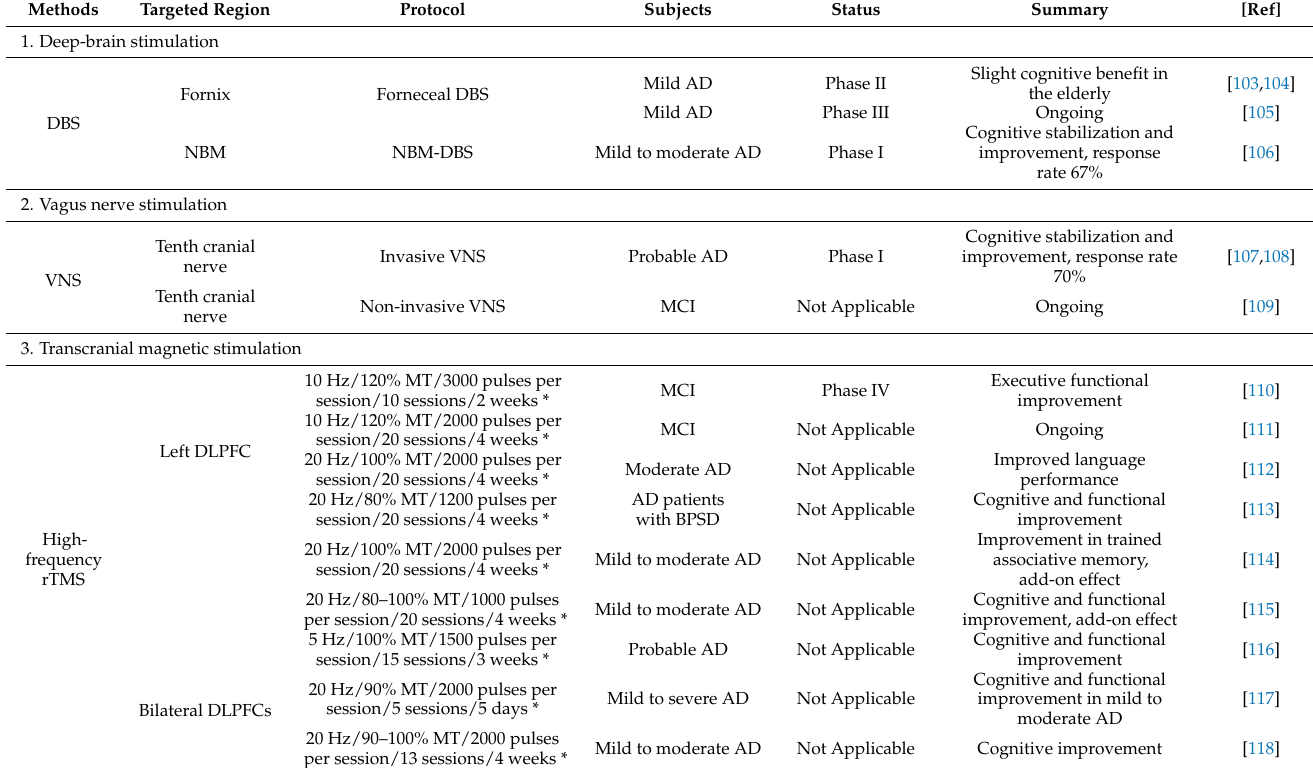
Table 2. Summary of non-pharmacological interventions against